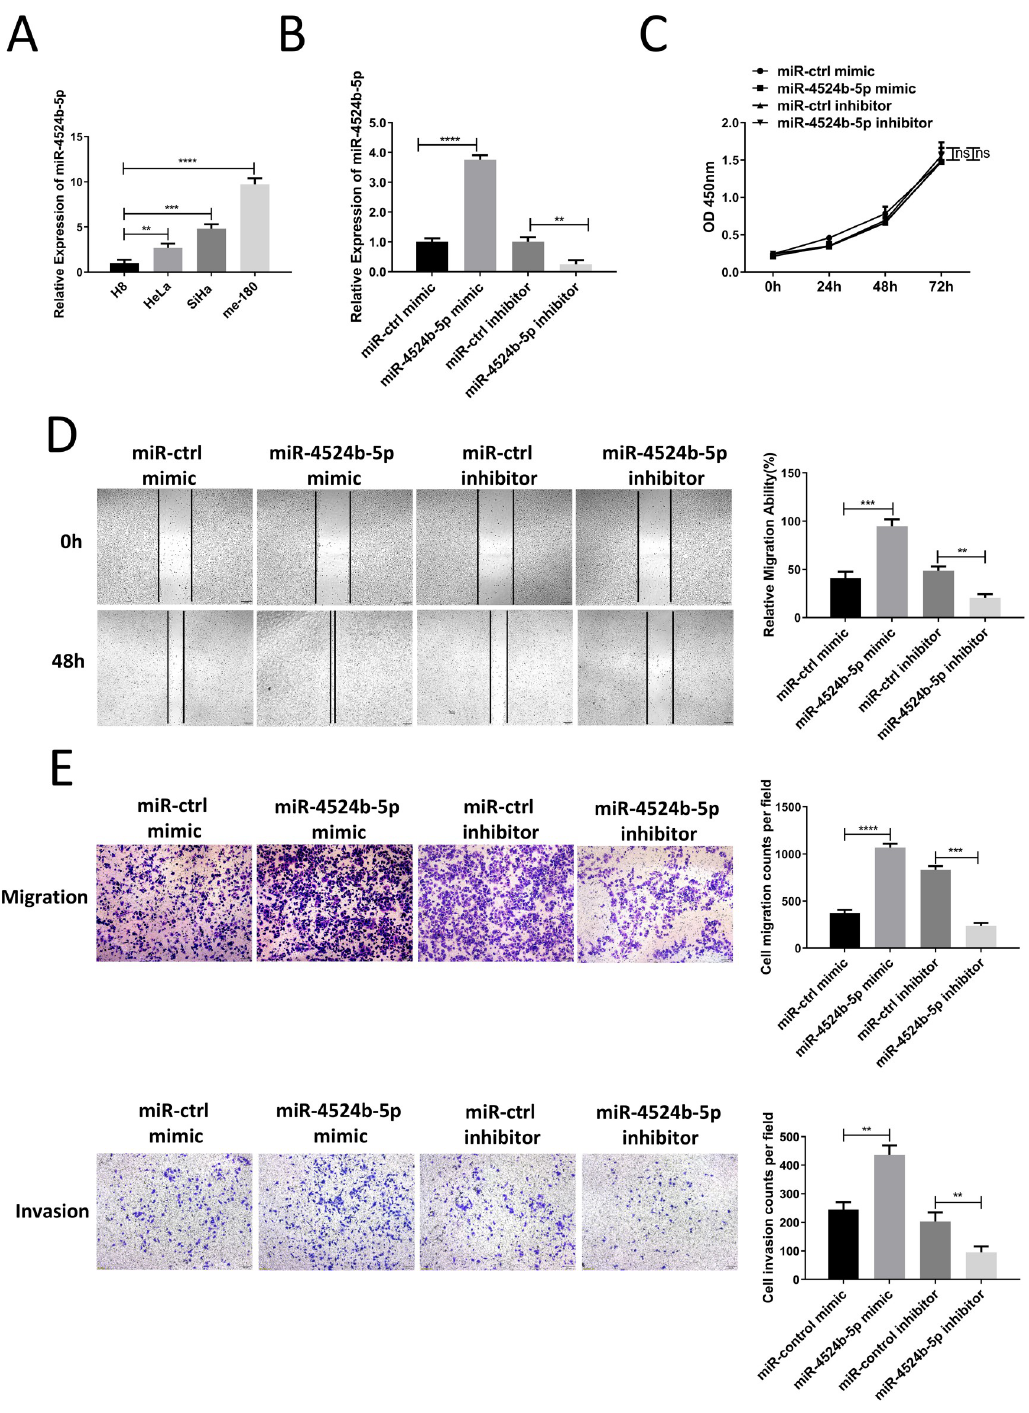
Fig 2. MiR-4524b-5p promoted SiHa cell migration and invasion in vitro, but did not affect its proliferation. (A) Relative expression of miR-4524b-5p in cervical cancer cell lines and normal cell lines. (B) Relative expression of miR-4524b-5p in SiHa transfected with miR-4524b-5p mimic or inhibitor. (C) Cell proliferation was examined using a CCK-8 assay. The proliferation of SiHa cells transfected with miR-4524b-5p mimic/miR-4524b-5p inhibitor compared with that of cells transfected with miR- control mimic/miR-control inhibitor. (D) Wound-healing assay measurement of the migration ability of SiHa cells transfected with miR-4524b-5p mimic or inhibitor for 48 h. (E) Transwell assay measurement of the migration and invasion ability of SiHa cells transfected with miR-4524b-5p mimic or inhibitor for 48 h. All values are presented as the means ± SEM, �� P < 0.01, ��� P < 0.001, ���� P < 0.0001.